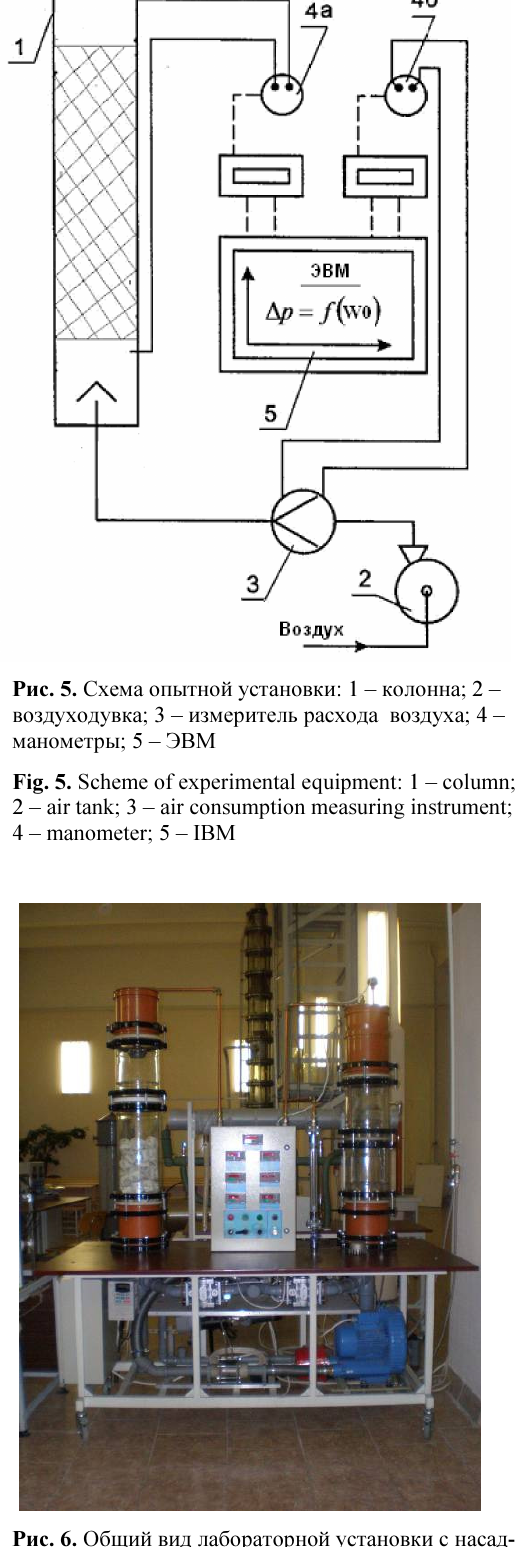
Fig. 6. General view of experimental equipment